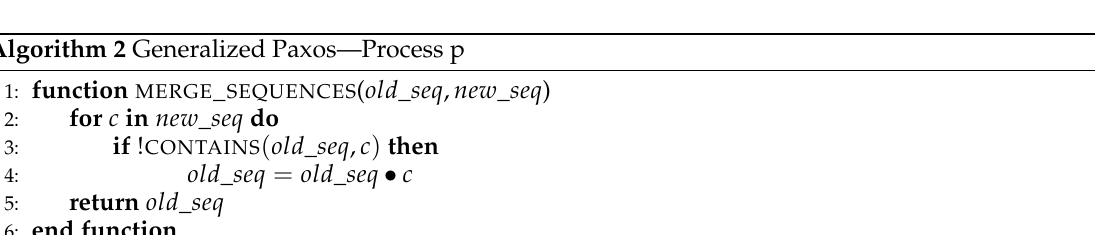
Algorithm 2 Generalized Paxos—Process